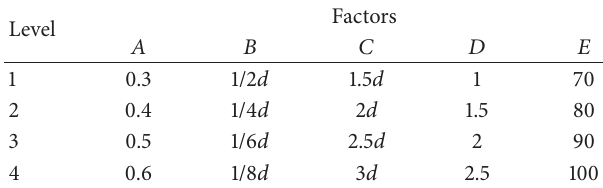
Table 1: Orthogonal test